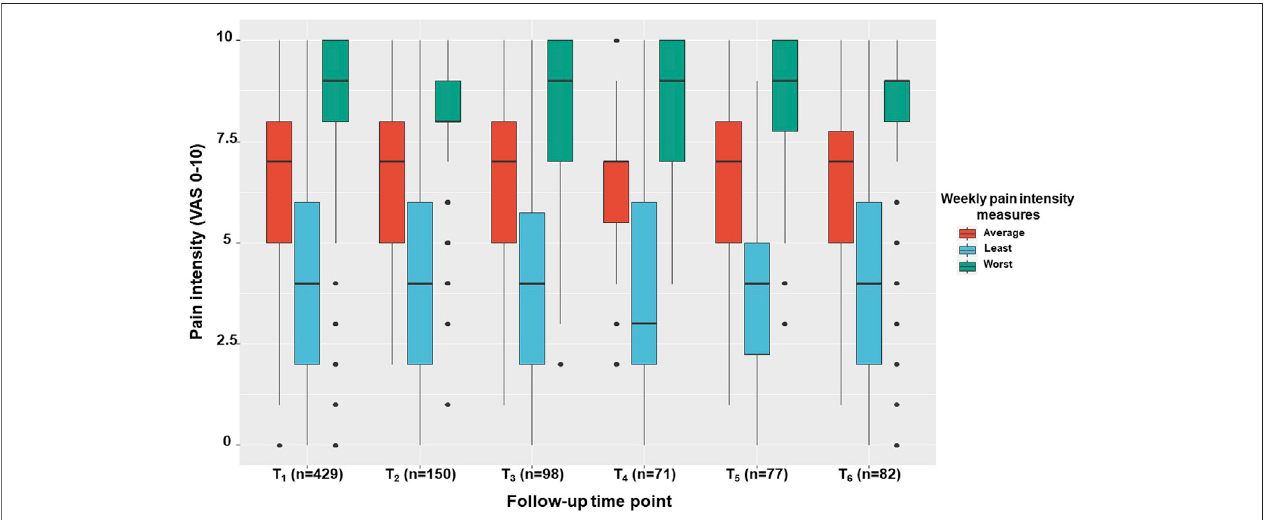
FIGURE 1 | Pain intensity measures across study period. The median, inter quartile range, total range and outliers for the average, least and worst pain intensities aredemonstratedforthestudysampleatonemonthintervalswithinasix-monthperiod.VAS,Visualanaloguescale;T 1 ,T 1 -T 6